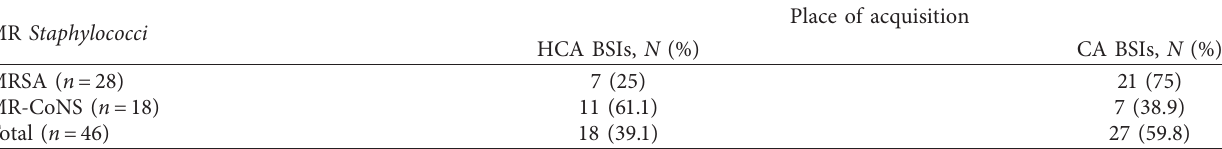
Place of acquisition